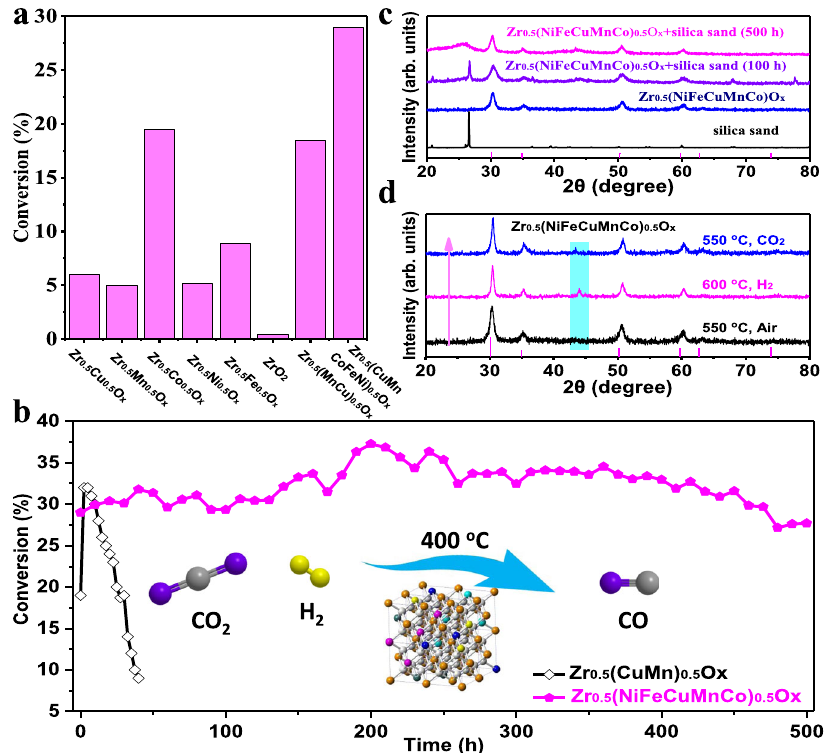
Fig. 9 Catalytic performance of doped ZrO 2 catalysts. a catalytic performance of Zr 0.5 Cu 0.5 O x , Zr 0.5 Mn 0.5 O x , Zr 0.5 Co 0.5 O x , Zr 0.5 Ni 0.5 O x, Zr 0.5 Fe 0.5 O x, Zr 0.5 (CuMn) 0.5 O x, and Zr 0.5 (NiFeCuMnCo) 0.5 O x in CO 2 hydrogenation at 400 °C. b P-XRD patterns of reused Zr 0.5 (NiFeCuMnCo) 0.5 O x samples after 100 h and 500 h on steam. c The P-XRD patterns of phase evolution between H 2 /CO 2 conditions. d Thermal stability tests of Zr 0.5 (NiFeCuMnCo) 0.5 O x and Zr 0.5 (CuMn) 0.5 O x in CO 2 hydrogenation. arb. units: arbitrary